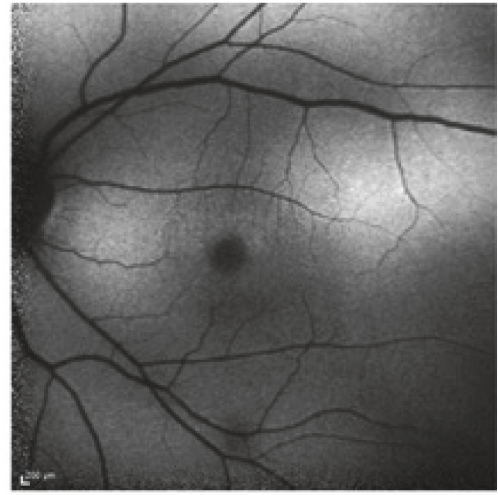
Figure 5: Autofluorescence image of the left